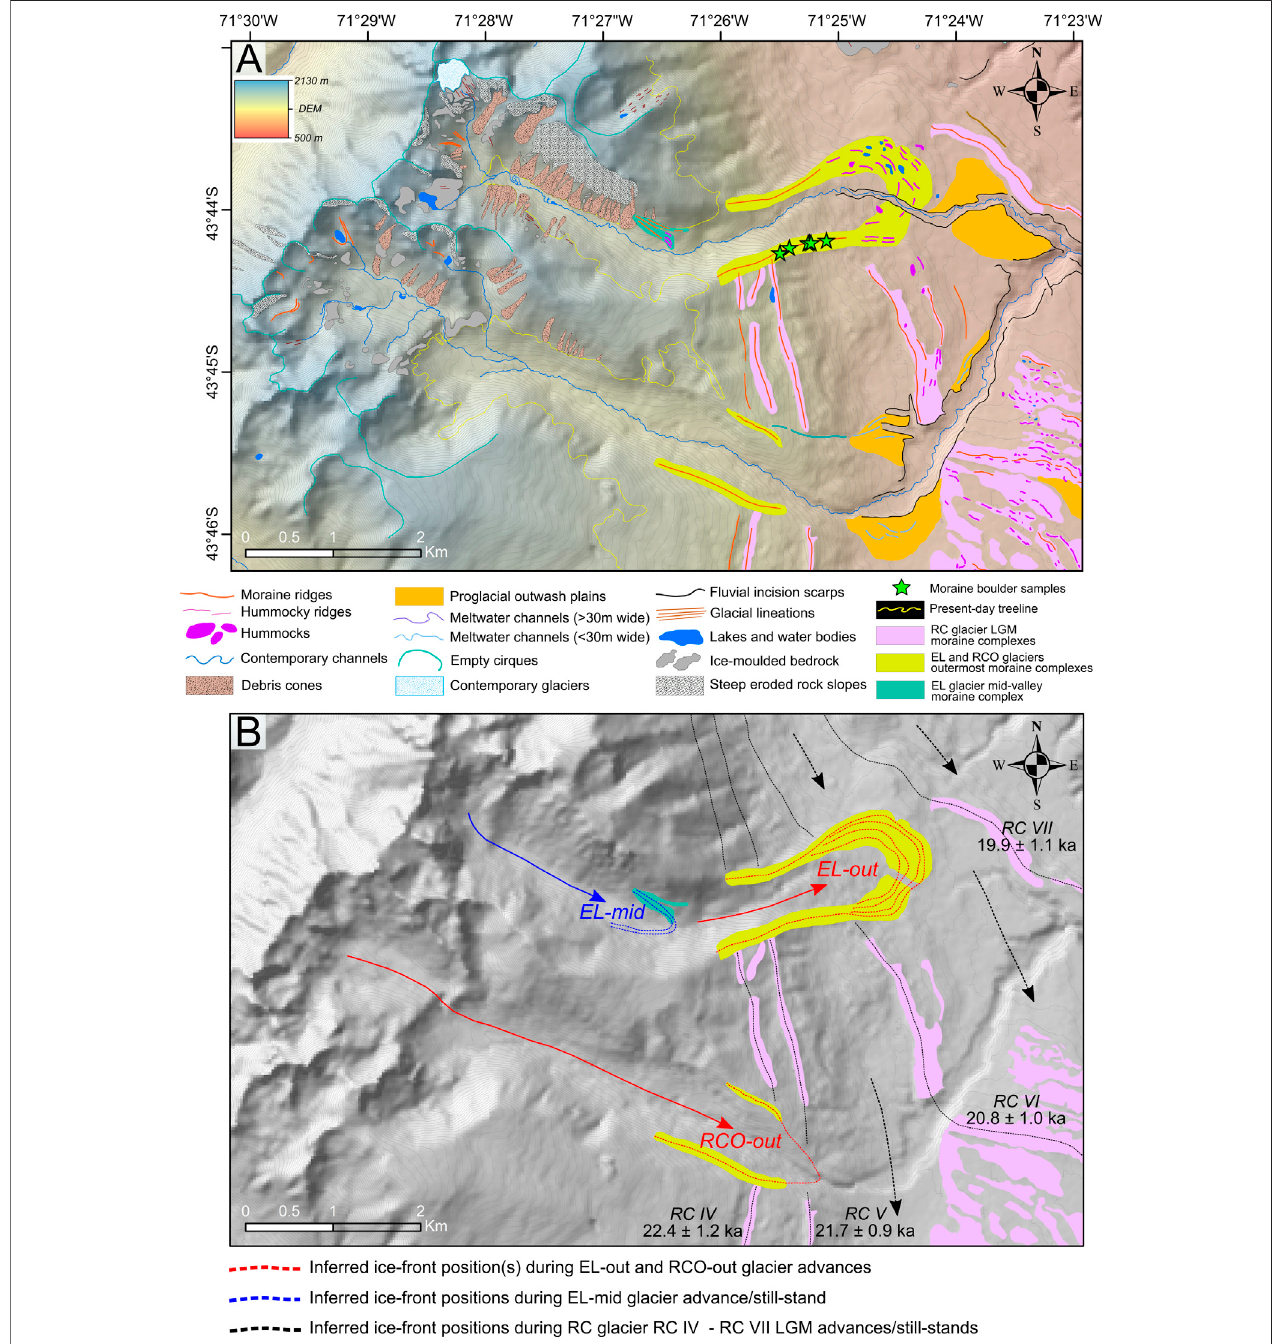
FIGURE2| GeomorphologicalmapoftheELandRCOvalleys,northeasternPatagonia(seelocationinwidercontext, Figure1 ). (A) DEMhillshade(AW3D30DEM, lightazimuth:315 ° ,incline:45 ° )andgeomorphologicalmapoftheELandRCOvalleys.LocationsofmoraineboulderssampledforTCNdatingareindicatedbygreenstar symbols. The variable colouring of moraine complexes (pink/yellow/green) highlights the stratigraphic order of distinct palaeo-glacier advances/stillstands according to our geomorphologicalinterpretations. (B) DEM hillshade, inferred moraine-complex stratigraphic relationships and former ice- fl owdirectionsofthe RíoCorcovado outlet glacier LGM advances/still-stands (black arrows), EL-mid advance/still-stand (blue arrow), EL-out and RCO-out advances (red arrows). The ages of the Río Corcovado LGM advances/still-stands are arithmetic mean ± 1 σ standard deviations of moraine boulder exposure age populations reported by Leger et al. (2021) following Bayesian age model correction. Spatial data are displayed in WGS84 and projected to UTM zone 19S.